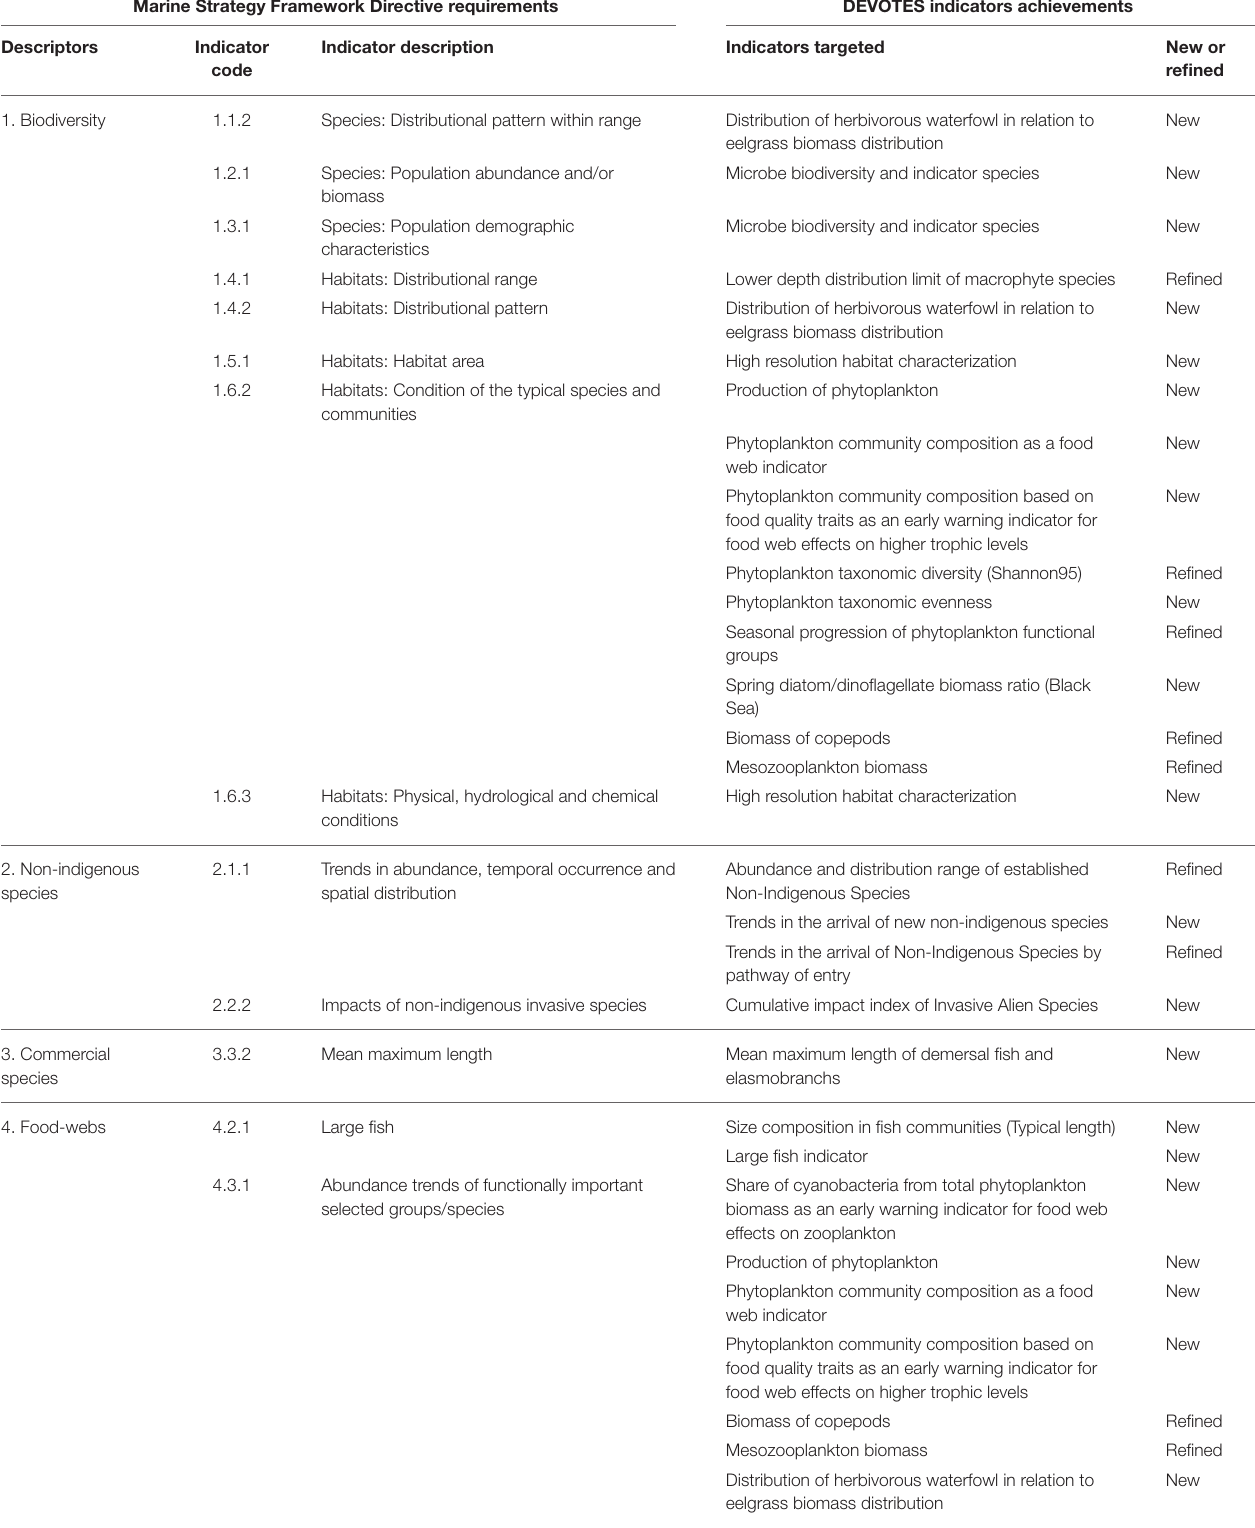
TABLE 1 | Indicators developed or refined within DEVOTES project, in relation to some of the indicators proposed within the Marine Strategy Framework Directive